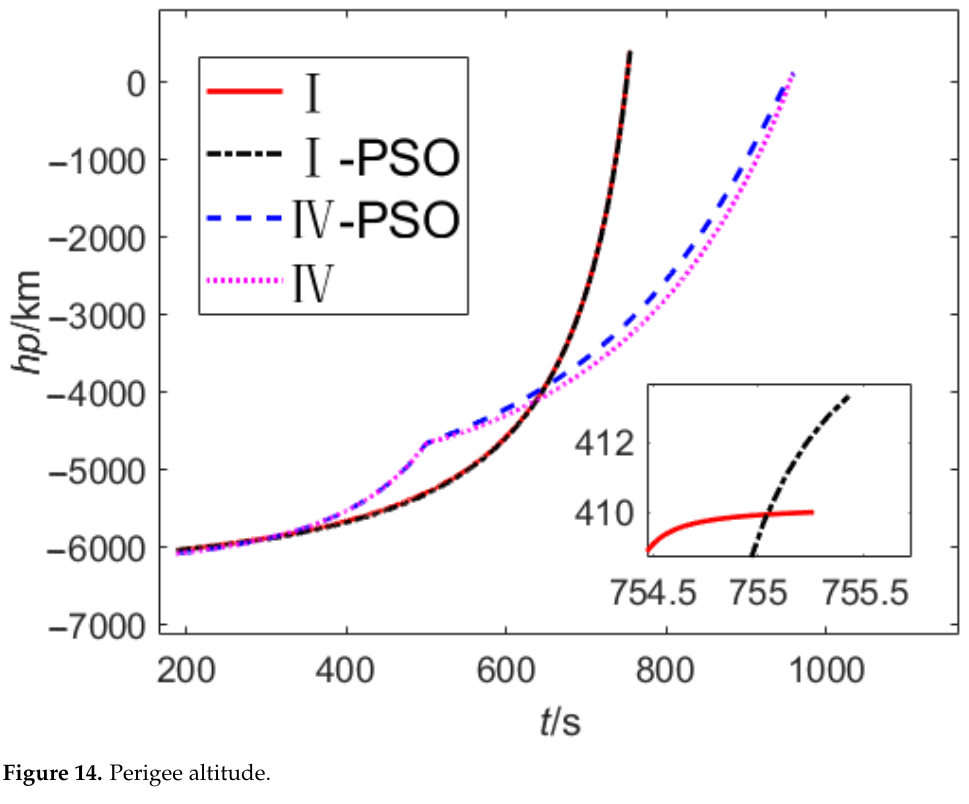
Figure 13. Flight trajectory and terminal orbit.